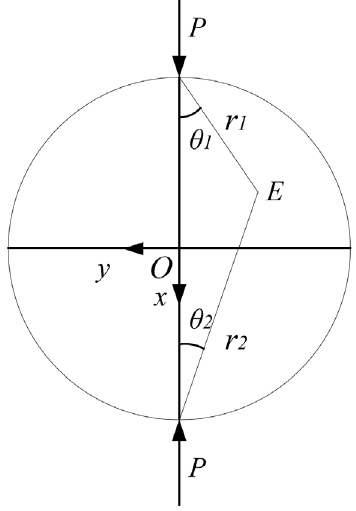
Figure 6. Force state of Brazil disc test.